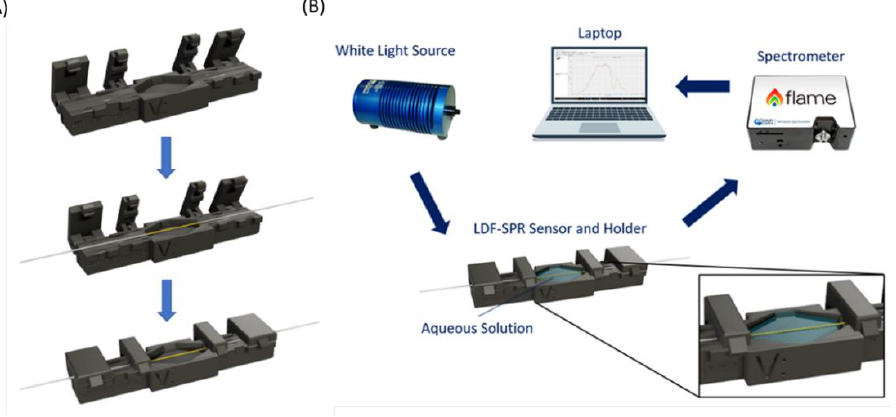
Figure 1. ( A ) The layout of the custom-designed holder used to fix the LDF-SPR sensor and realize the measurement cell. ( B ) The outline of the experimental setup.